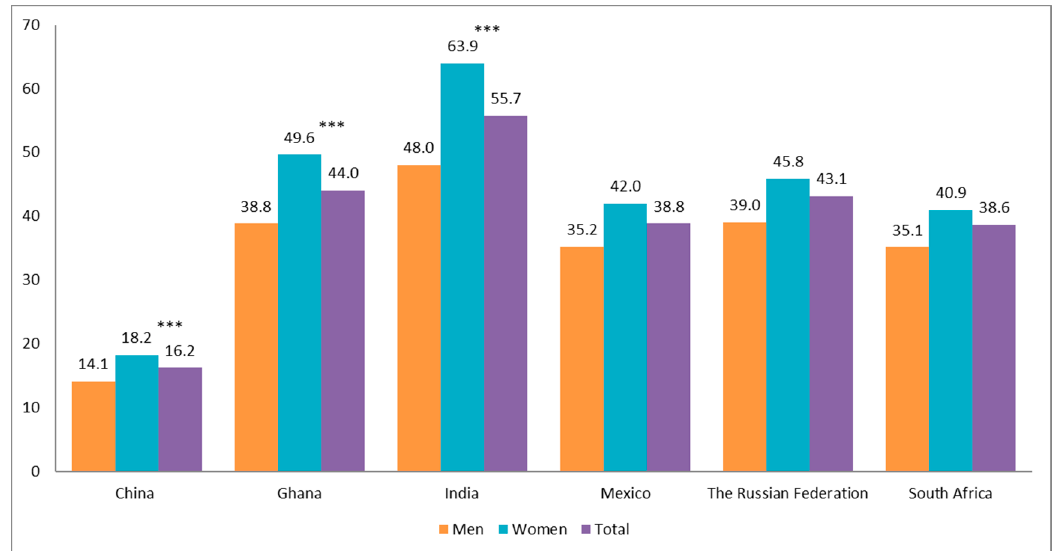
Figure 1. Prevalence of ADL disability among women and men aged 50+, by country, SAGE Wave 1 (2007–2010). Table 2. Multivariable logistic regression of the association between sociodemographic factors, social capital, health behaviours, and ADL disability among respondents aged 50 + , by country, SAGE Wave 1.